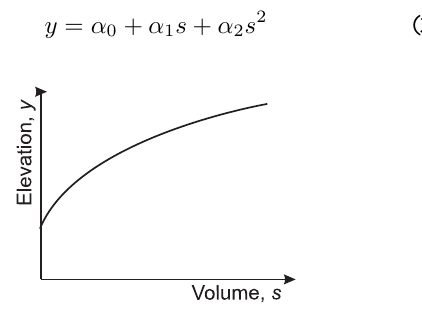
Fig. 1: Typical reservoir elevation-storage